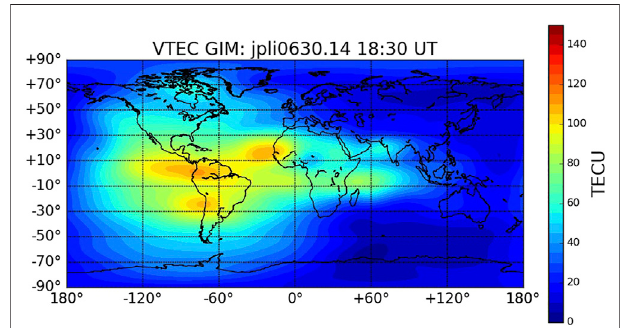
FIGURE 1 | Example of GIM on 4 March, 2014. TEC is shown in TEC units (TECU), where 1 TECU= 10 16 electrons/m 2 . Horizontal and vertical axes correspond to geographic longitude and latitude, correspondingly.